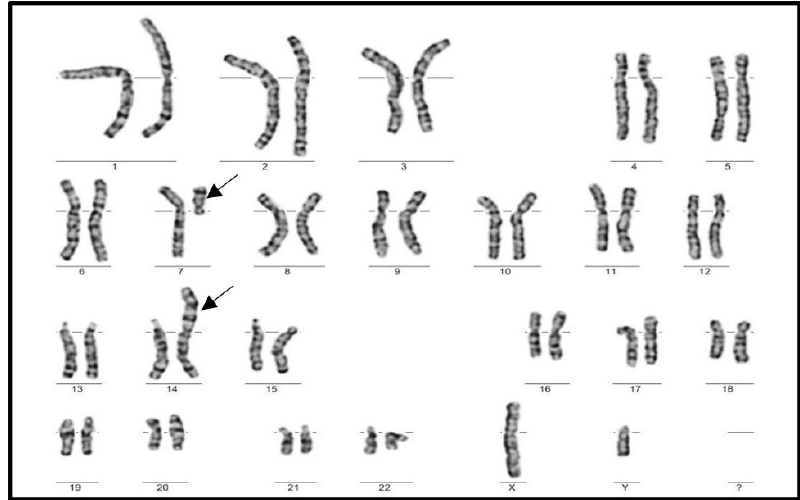
Figure 3. Karyogram of a male patient with the most frequent SCT, t(7;14).